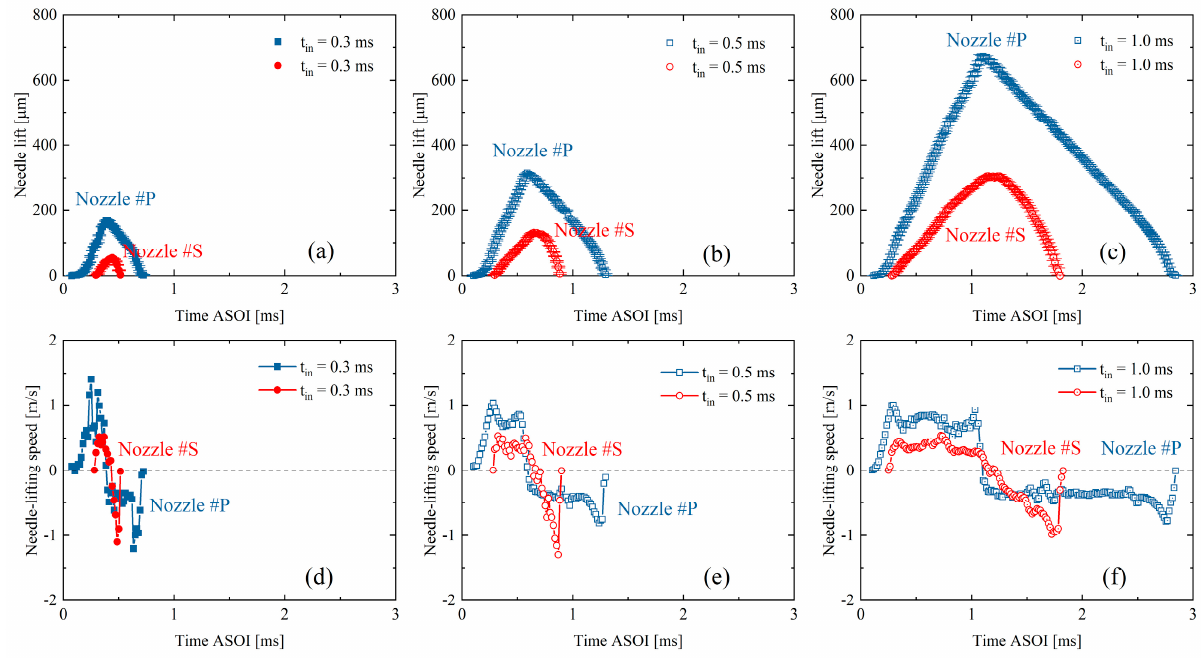
Figure 3. Results of needle motion: ( a − c ) needle lift, and ( d − f ) needle lifting speed.